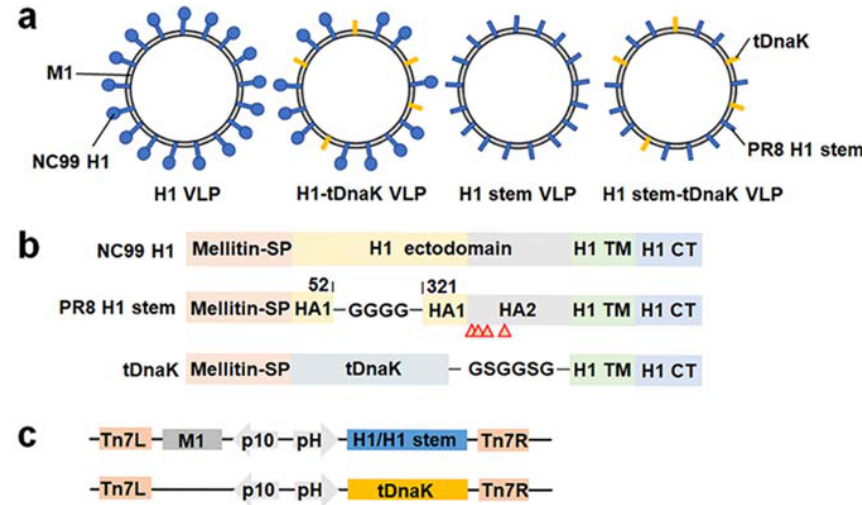
Figure 1. The construction of the cVLPs. ( a ) Schematic diagrams of the chimeric H1 VLP, H1-tDnaK VLP, H1 stem VLP, and H1 stem-tDnaK VLP. ( b ) Schematic diagrams of the designs of the full-length NC99 H1, PR8 H1 stem, and membrane-anchored tDnaK. Red arrows indicate site-mutations, I61Y, F63T, V66T, and L73Y in PR8 HA2. ( c ) Schematic diagrams of the designs of recombinant pFastBac Dual plasmids encoding M1 and H1/H1 stem, or membrane ‐ anchored truncated DnaK